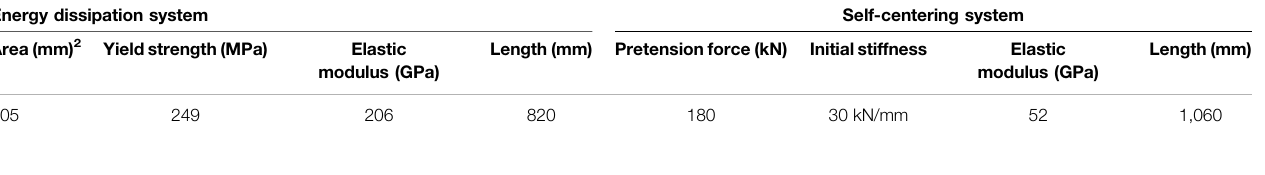
TABLE 4 | Mechanical properties of the tested SC-BRB of Xie (2018). Energy dissipation system